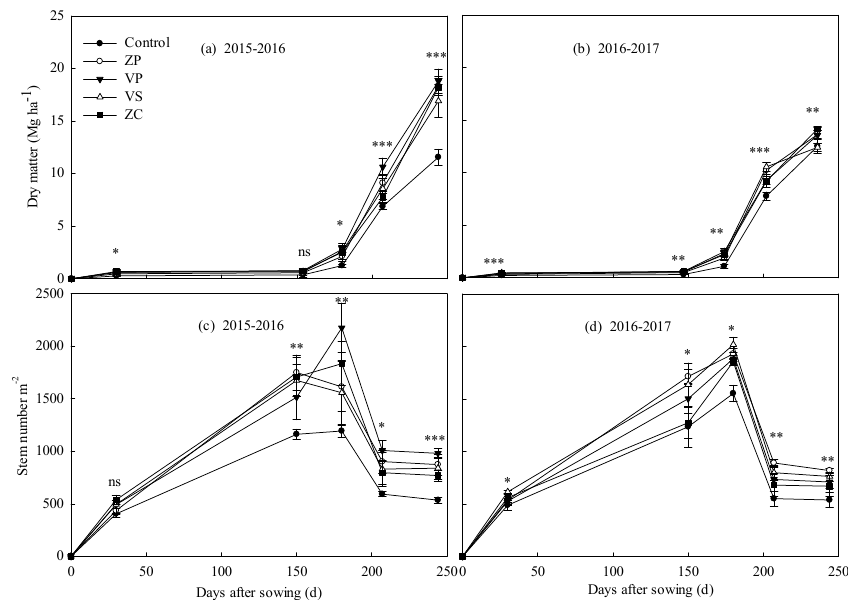
Figure 2. Dynamics of dry matter accumulation ( a , b ) and stem number per square ( c , d ) in response to different amendment treatments in 2015–2016 and 2016–2017. Vertical bars indicate ±SD of the mean. Different letters with each growth stage represent significant differences as determined by Duncan’s test at the 5% level. ns, not significant; *significant at p < 0.05; **significant at p < 0.01; ***significant at p < 0.001.